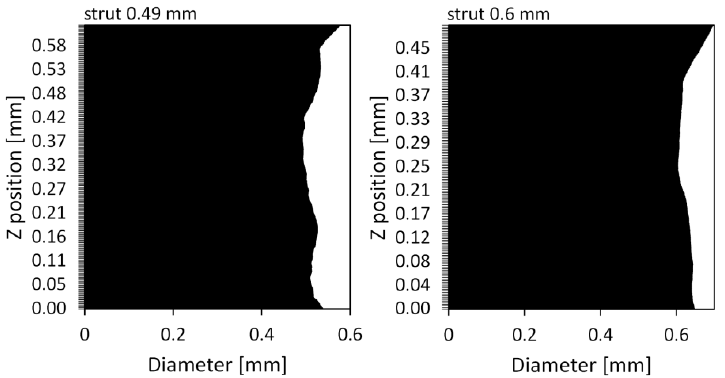
Figure 4. Surfaces of the struts and internal micropores recreated based on microtomographic images.